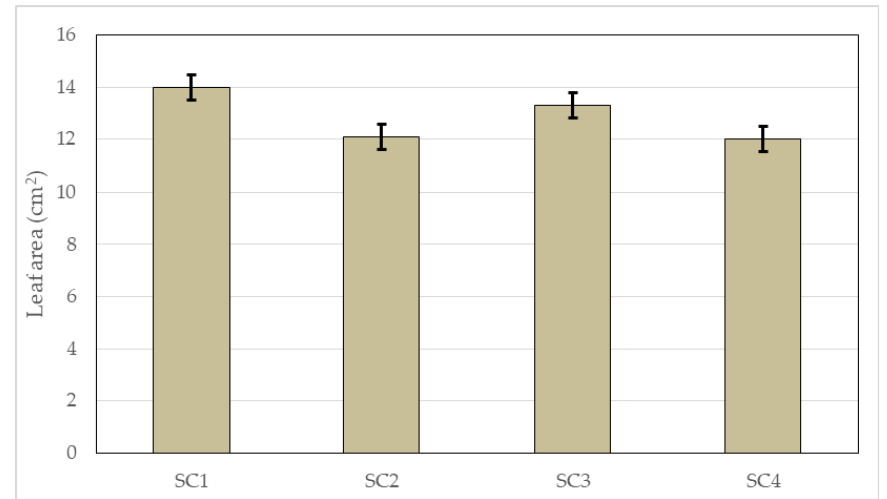
Figure 5. Mean value of leaf area related to the four Substrate Compositions (SC). The bars stand for standard deviation values ( n = 4).